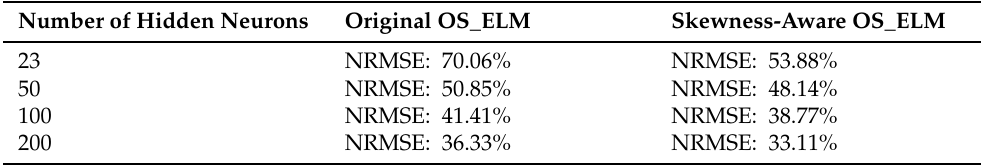
Table 3. Prediction Accuracy Comparison between Original OS_ELM and Skewness-aware